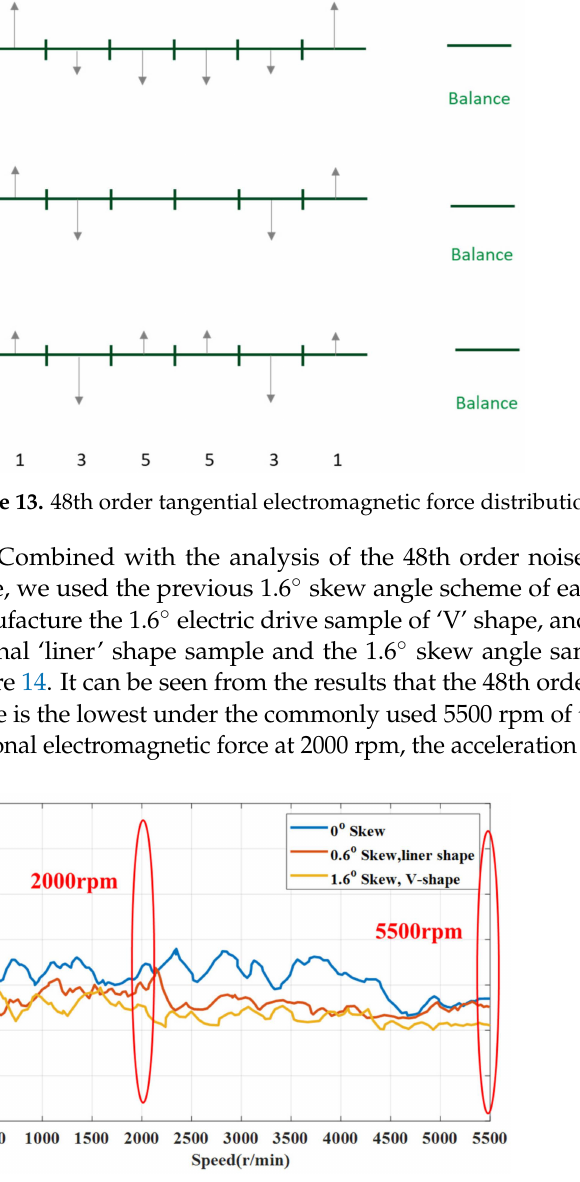
Figure 14. Noise result of different rotor